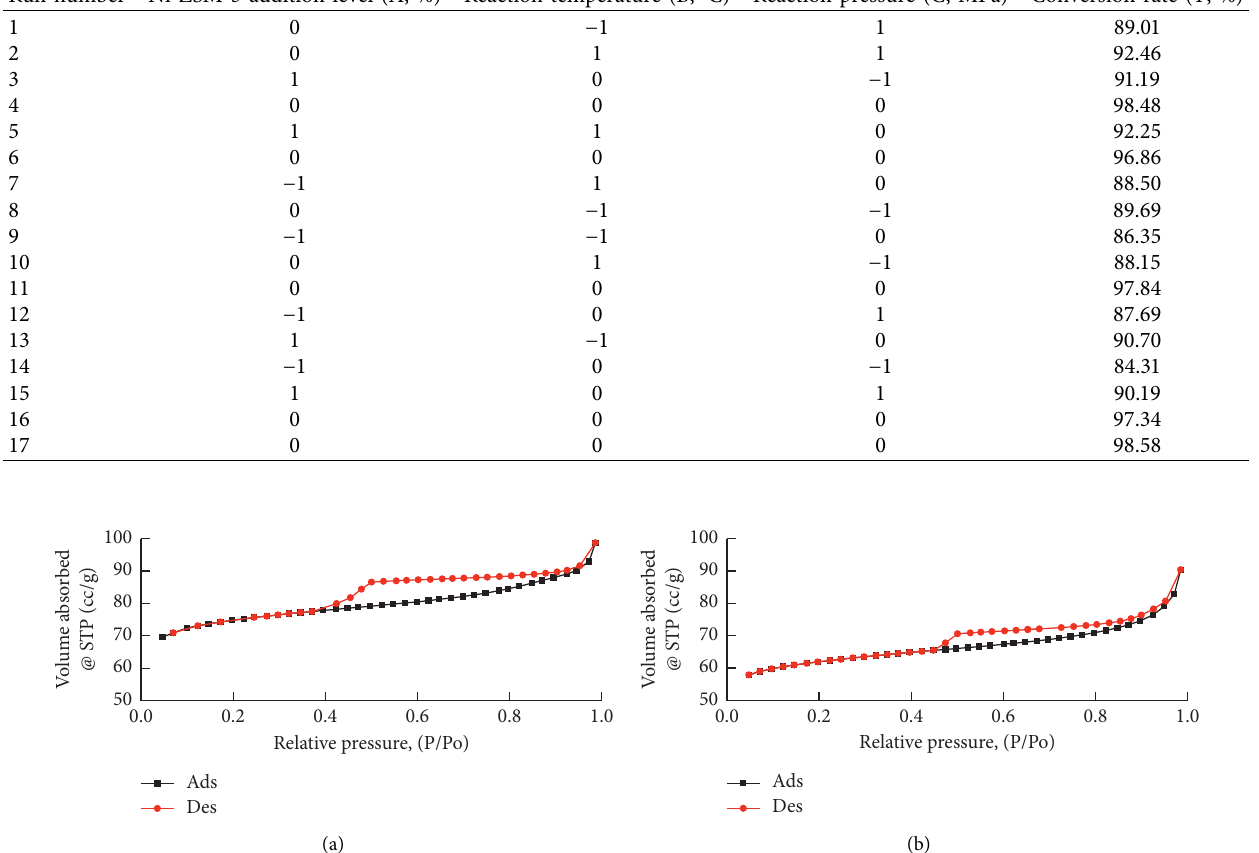
Table 2: Response surface experiment design and results.